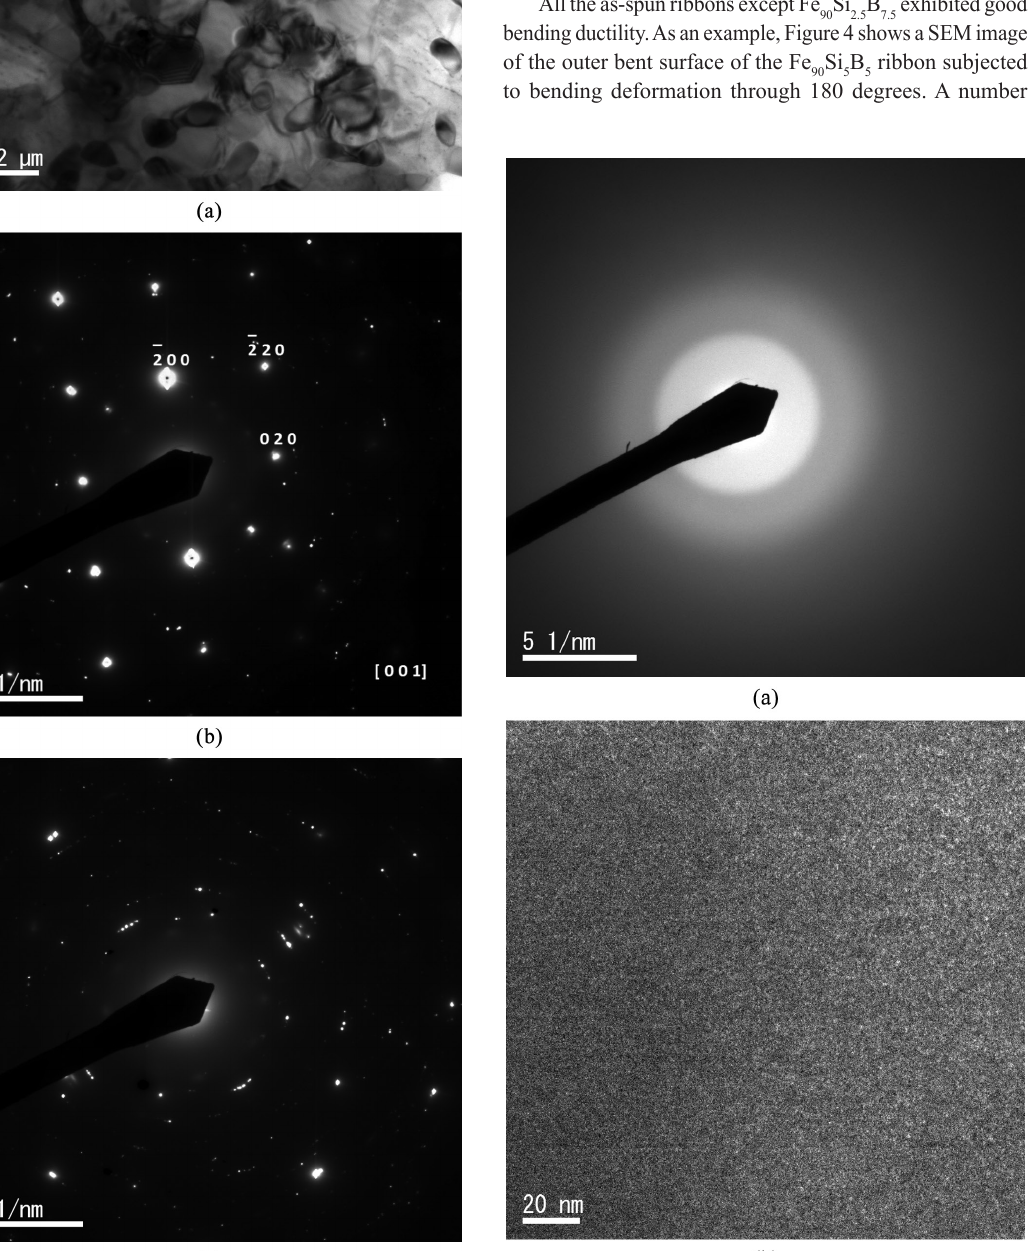
Si B ribbon: (a) SAED of diffuse 90 5 5